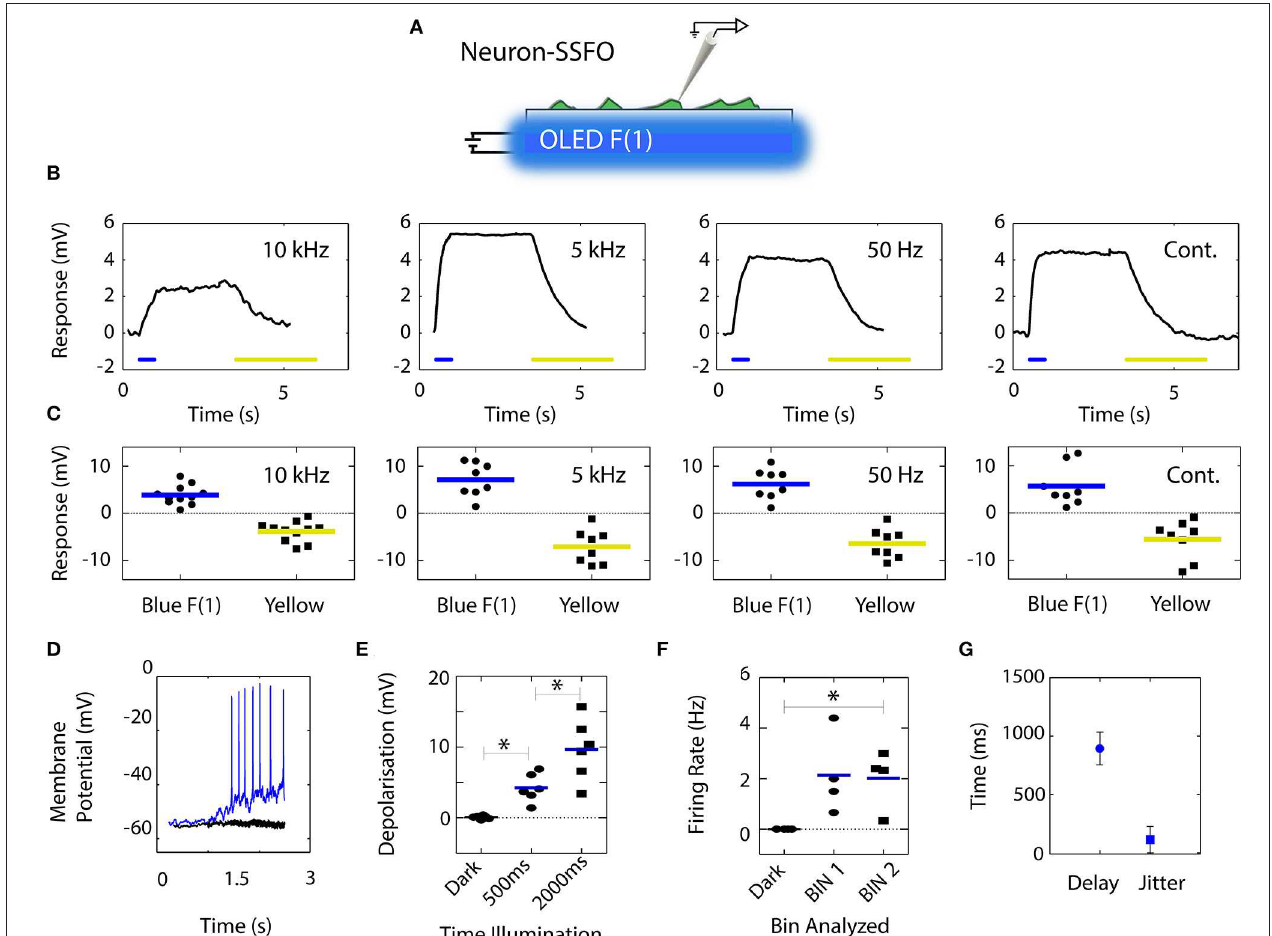
FIGURE 4 | Depolarization of SSFO-expressing neurons by blue OLED illumination at various pulse rates. (A) Neurons were transfected with SSFO, stimulated by a blue OLED, and recorded in current-clamp configuration. (B) Representative responses from individual neurons. At all tested frequencies, 500ms of blue light stimulation was sufficient to depolarize the neurons, leading to sustained activation that extended beyond the pulse stimulus; activation could be fully reversed by yellow light stimulation. (C) Individual neurons (symbols) and mean (colored lines) amplitudes of blue light-induced depolarization in response to 500ms stimuli and yellow light-induced hyperpolarization in SSFO-expressing neurons ( n = 8–11). (D) Sample recording from a mature neuron transfected with SSFO (blue trace) and illuminated for 2s that successfully reached the firing threshold. The black trace represents the response of a control mock-transfected neuron. (E) Effects of stimulus length on the extent of depolarization, excluding action potentials, of SSFO-expressing neurons in response to 2s stimuli (symbols and lines represent individual neurons and the mean, respectively). Depolarization increased significantly with the time of illumination ( n = 6). (F) The firing rate of SSFO-expressing neurons increased significantly during prolonged illumination. The individual values (symbols) and mean (line) firing are shown for 1s bins before (dark) and during the blue light stimulus ( n = 4). (G) Quantification of the delay and jitter of action potential firing based on the first spike per stimulus calculated across all recorded